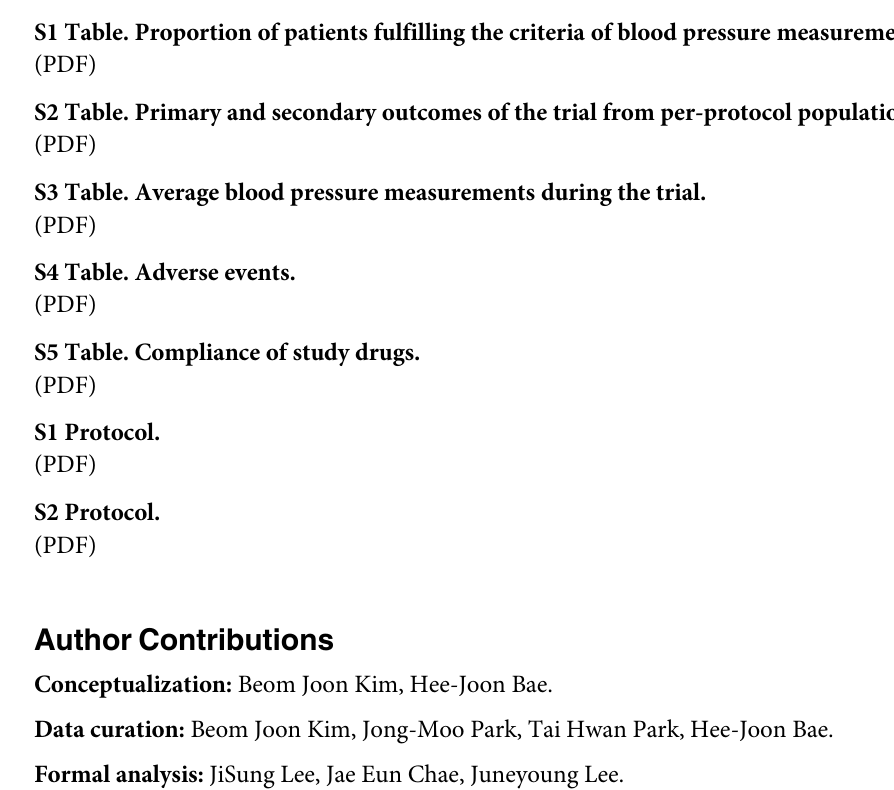
S1 Table. Proportion of patients fulfilling the criteria of blood pressure measurement. S2 Table. Primary and secondary outcomes of the trial from per-protocol population. S3 Table. Average blood pressure measurements during the trial. S4 Table. Adverse events. S5 Table. Compliance of study